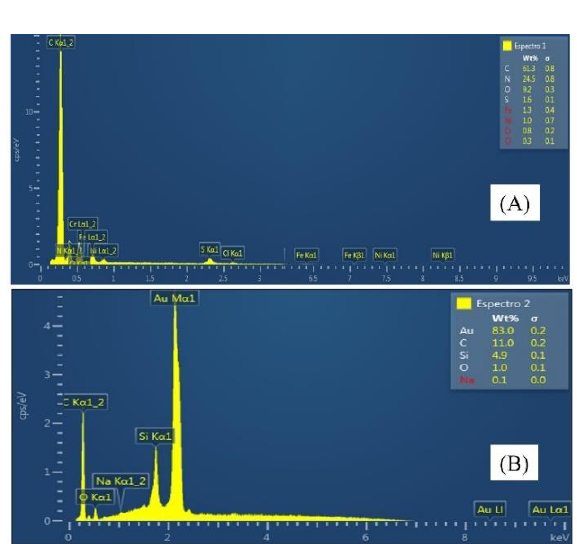
Figure A1. EDS spectra were obtained for the characterization of the electrode modified with PPy ( A ) and the electrode modified with PPy/AuNPs ( B ).